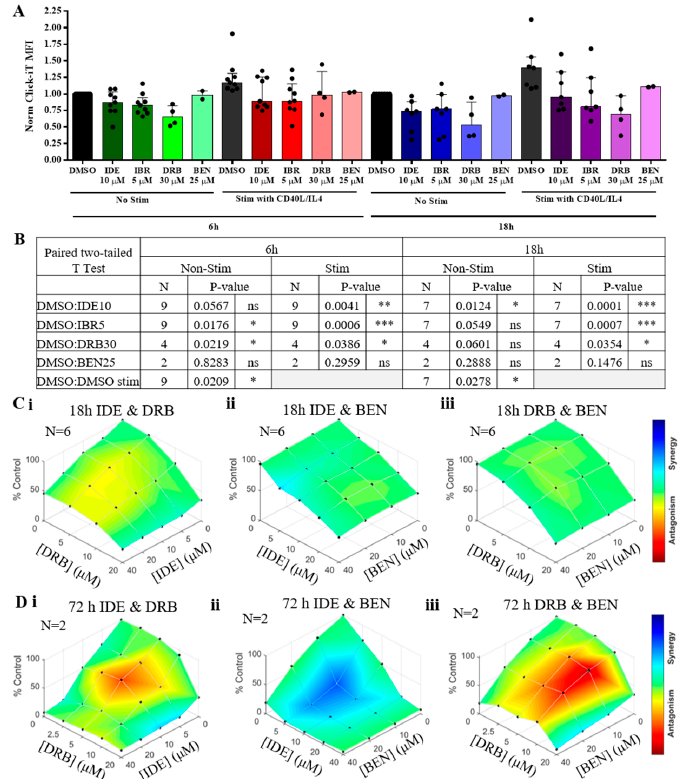
Figure 6. CD40 / interleukin 4 (IL4) increases DNA transcription in chronic lymphocytic leukemia (CLL), which is inhibited by idelalisib (IDE) and ibrutinib (IBR) but not by bendabustine (BEN). ( A ) Changes in global transcriptional activity in primary CLL cells 6 or 18 h post drug treatment. Click-iT ® was measured in viable cells and samples were normalized (Norm) to the dimethyl sulfoxide (DMSO) control for each time-point (black bars). Bars represent median and interquartile range and dots represent individual samples. ( B ) Statistical table from A . not significiant (ns) = p > 0.05, * = p ≤ 0.05, ** = p ≤ 0.01 and *** = p ≤ 0.001 ( C,D ) Average Combenefit plots of i. 5,6-Dichloro-1- β - d-ribofuranosylbenzimidazole (DRB) and IDE, ii. IDE and BEN, or iii DRB and BEN in 6 primary CLL patients at 18 h post drug treatment ( C ) or in 2 primary CLL patients 72 h post-drug treatment ( D ). Blue—synergy, green—additivity and,